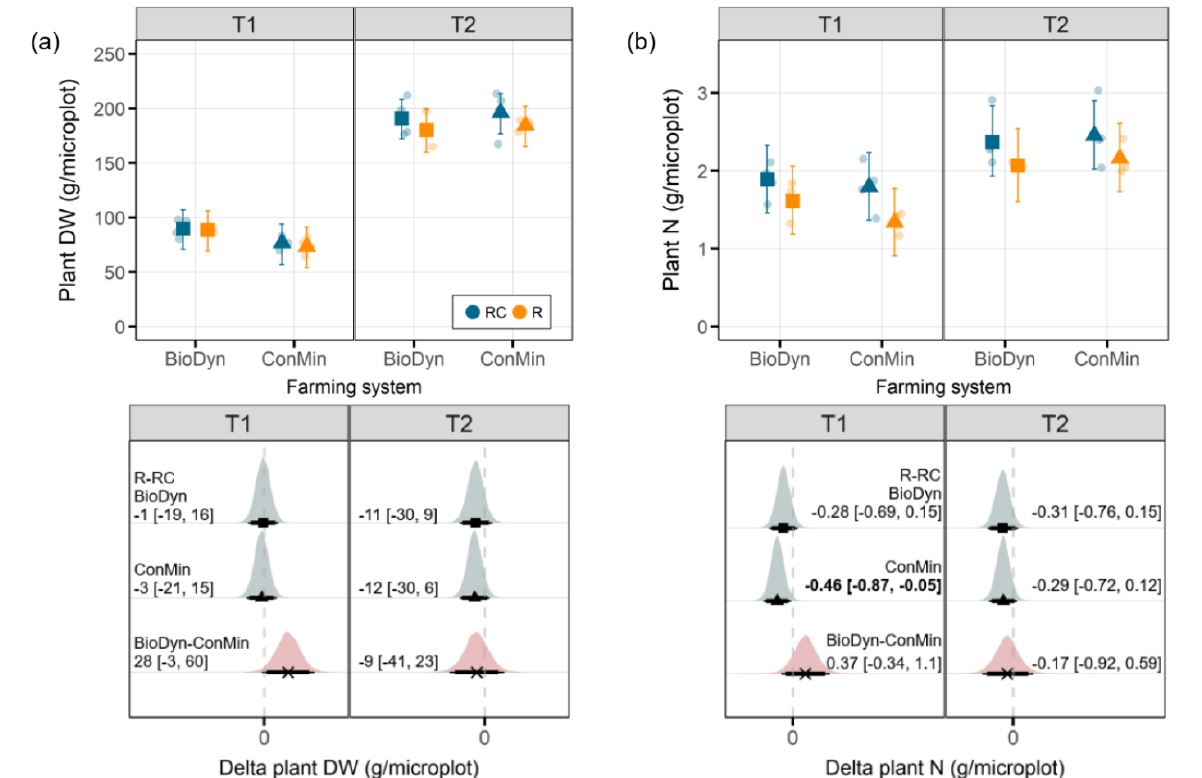
Figure 5. Upper panels: ( a ) total plant (sum of root and shoot) dry weight (DW), ( b ) total plant nitrogen (N) content and semi-transparent points: raw data and lower panels: differences in total plant DW and plant N in response to drought treatments (R-RC in BioDyn: rectangle and R-RC in ConMin: triangle), along with the differences between the farming systems (BioDyn-ConMin: cross; calculated as averages over the drought treatments). All data are medians of the posterior distribution with 95% credible intervals (CrIs), factor system: biodynamic farming system (BioDyn) and conventional farming system (ConMin), factor drought: rainout shelter control (RC) and rainout shelter (R) and factor sampling: first sampling (T1) and second sampling (T2). Credible intervals in bold exclude zero.